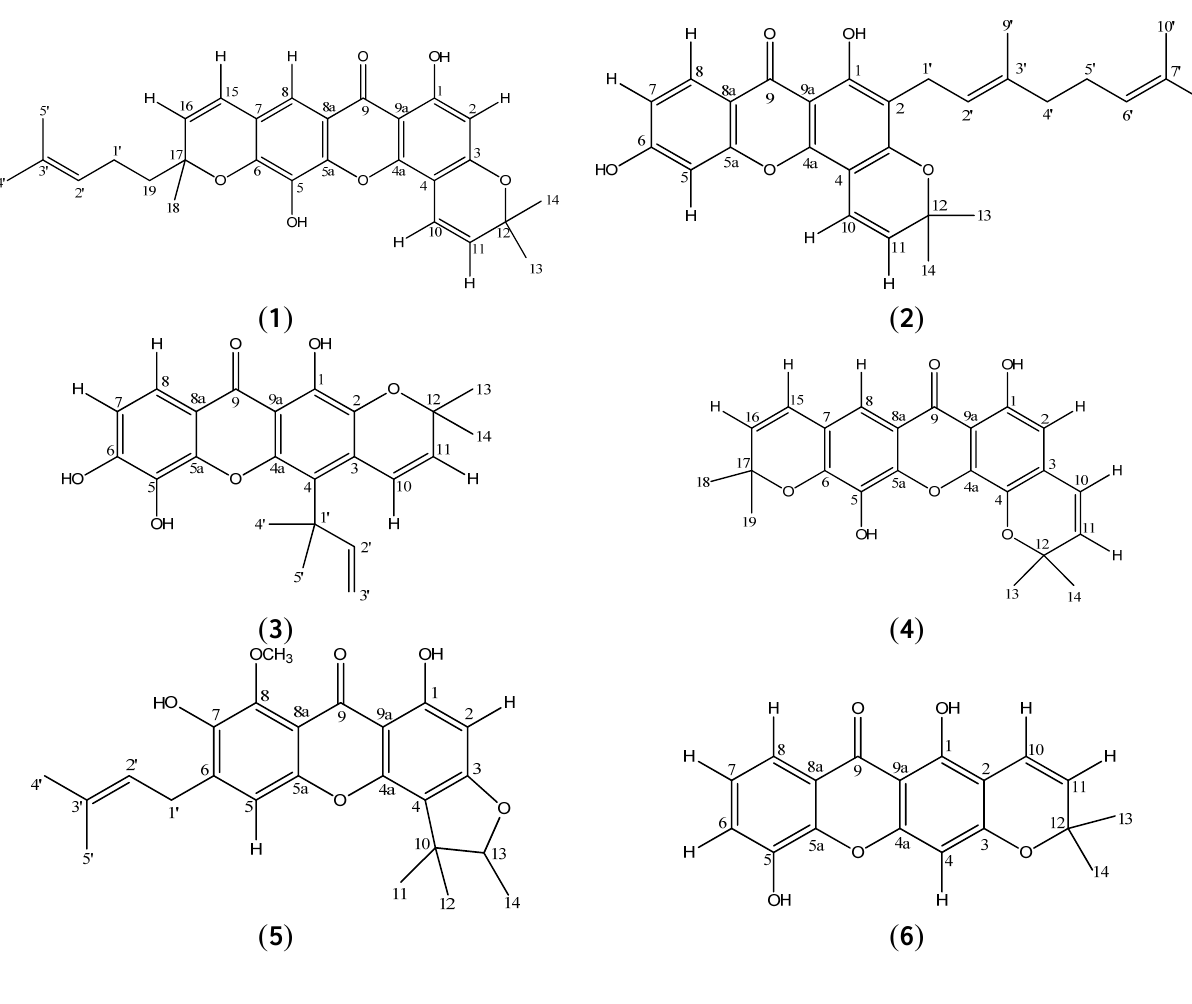
Figure 1. Structures of compounds 1 – 11